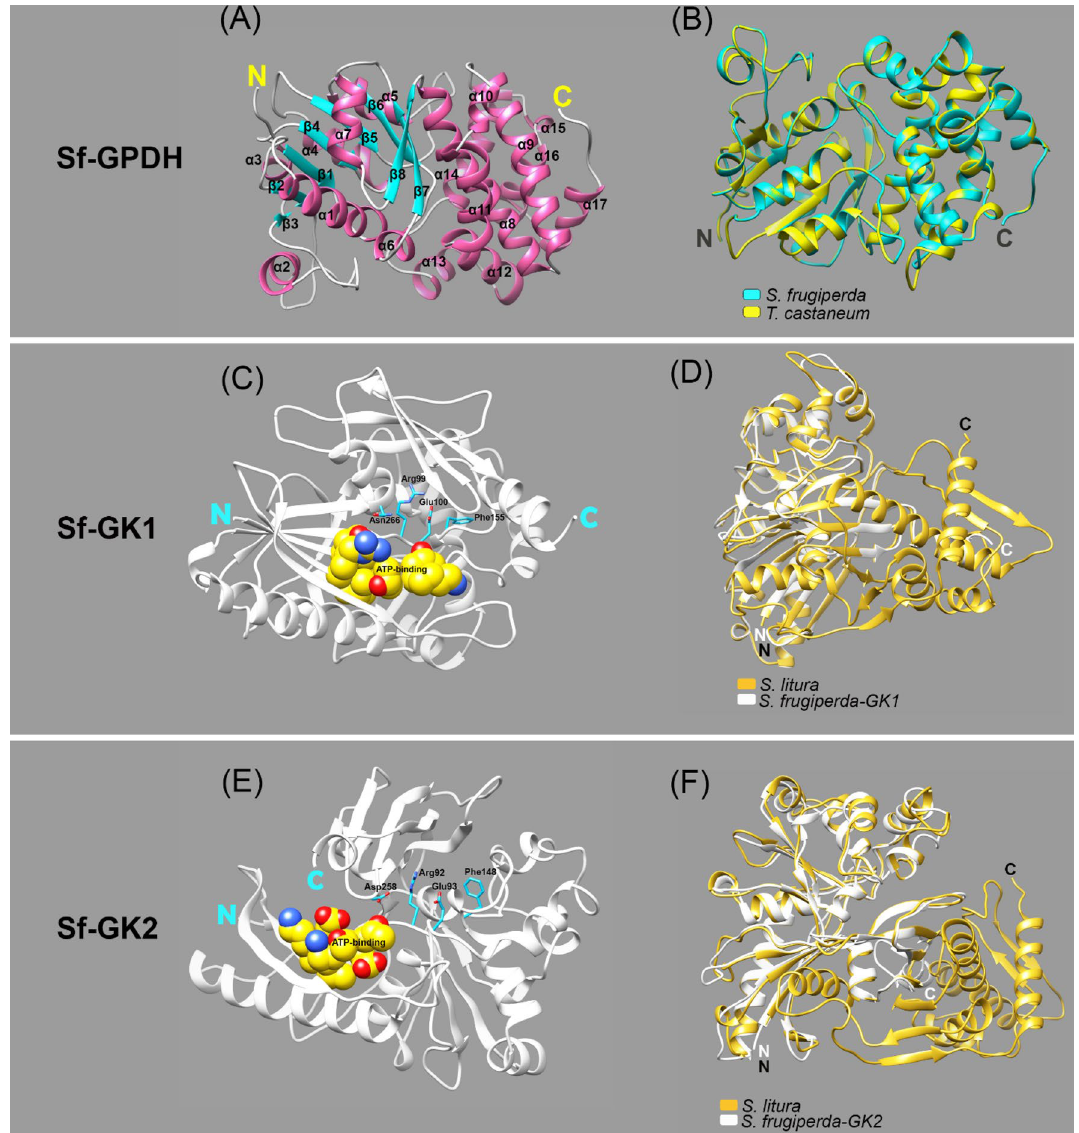
Figure 3. Three-dimensional analysis of glycerol biosynthesis genes of Spodoptera frugiperda . ( A , C , and E ) The functional domains of Sf-GPDH, Sf-GK1, and Sf-GK2 were demonstrated, respectively. ( B , D , and F ) the Sf-GPDH, Sf-GK1, and Sf-GK2 proteins respectively, were compared with same protein from another well- known insect, including Tribolium castaneum and Spodoptera litura . Blue and pink region in ( A ) indicate beta sheet and alpha helices, respectively. In ( C and E ), the glycerol binding residues were indicated with blue atoms as well as yellow part that showing ATP-binding domains. N and C are an abbreviation for N-terminus and C-terminus of amino acid sequences. These models were made using SWISS-model web database. Three dimensional constructs were made using Chimera, version Sf-GK2, However the mortality decreased significantly when the larvae injected with dsRNA specific to Sf-GK1 after RCH treatment than to control (Fig. 7C). Following RCH treatment, the SCP increased. The effect of RCH on SCP was evaluated in all devel- opmental stages including both sexes in pupal and adult stages (Table 1). Egg, first instar and pupal stages exhib- ited SCP at lowest temperature than other developmental stages. The data showed that supercooling capacity was unaffected by RCH treatment in egg, first and second instar, male pupae, and female adult whereas SCP temperature in the others was significantly reduced (Table 2). From these data, we found that RCH treatment is often accompanied by elevated SCPs. To investigate the involvement of glycerol biosynthesis genes in SCP, RNAi-treated larvae (L3 to L6) were incubated at RCH conditions and their SCP was assessed (Table 3). The SCPs of larvae injected with dsRNA specific to glycerol biosynthesis genes, specifically dsGPDH and dsGK2, were significantly lower than those of dsEGFP-injected larvae, suggesting that glycerol biosynthesis genes elevate